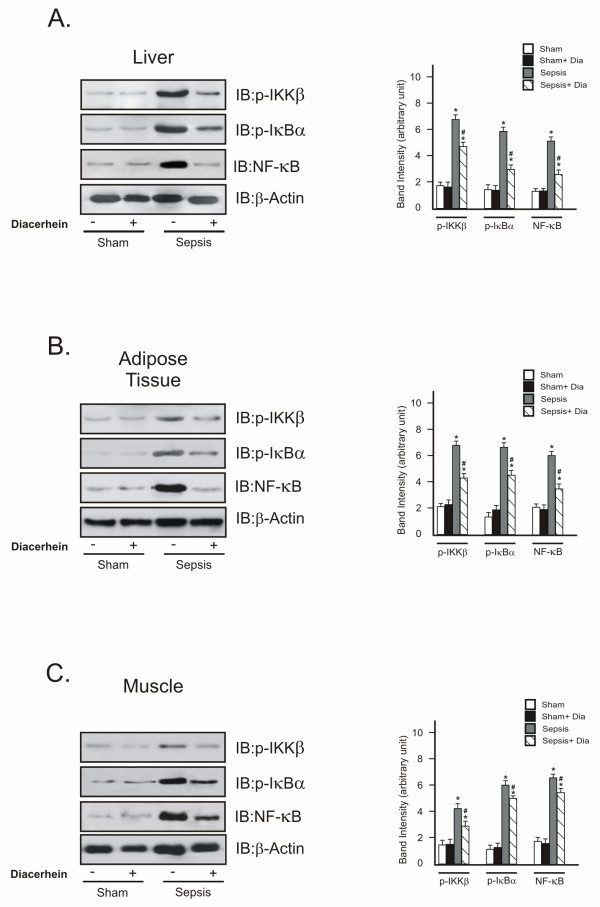
Effects of diacerhein treatment on the IKK/NF-κB pathway signaling in the CLP rat. Representative blots show the IKKβ, IκB phosphorylation, and protein expression of NF-κB in liver (A), adipose tissue (B), and muscle (C) of sham and septic rats. Blots were stripped and reprobed with β-actin (lower panels) to confirm equal loading of proteins. Data are presented as mean ± SEM from six to eight rats per group. *P < 0.05 versus Sham/Vehicle; #P < 0.05 (Sepsis/Veh versus Sepsis/Dia). IB, immunoblot; Sham, Sham/Vehicle; Sham+Dia, Sham/Diacerhein; Sepsis, Sepsis/Vehicle; Sepsis+Dia, Sepsis/Diacerhein.